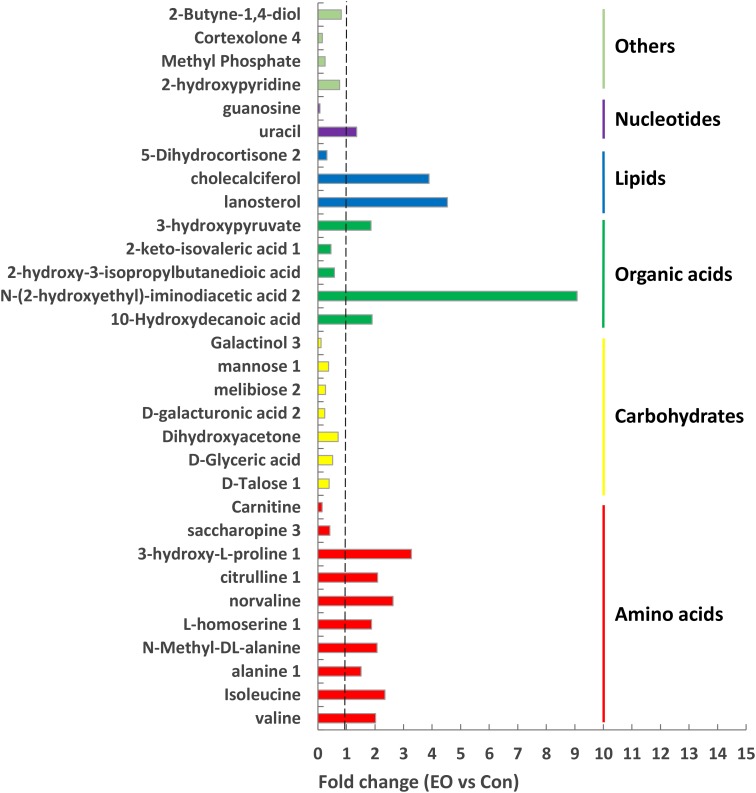
Significantly differential metabolites in the colon of weaned piglets fed with or without dietary EO. Metabolites accountable for class discrimination with VIP > 1 and P < 0.05 were listed. Con: the basal diet; EO: the basal diet supplemented with essential oils.